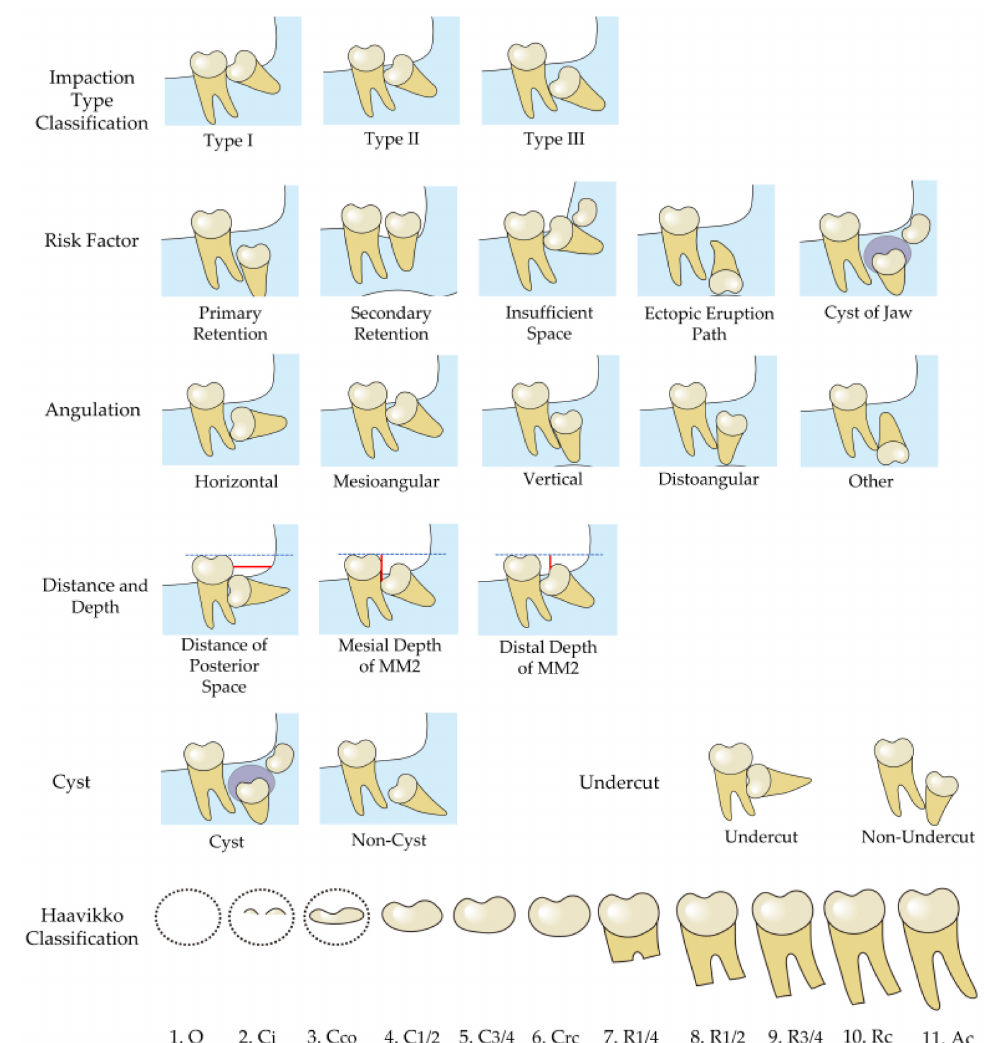
Figure 2. Data collection of MM2 impaction. Dash blue lines indicate the occlusal plane; red lines indicate distance or depth.